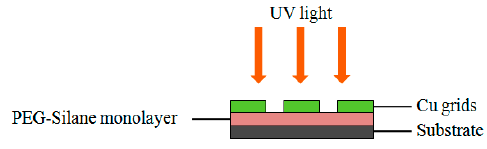
Figure 2. Schematic illustration of UV arrays.